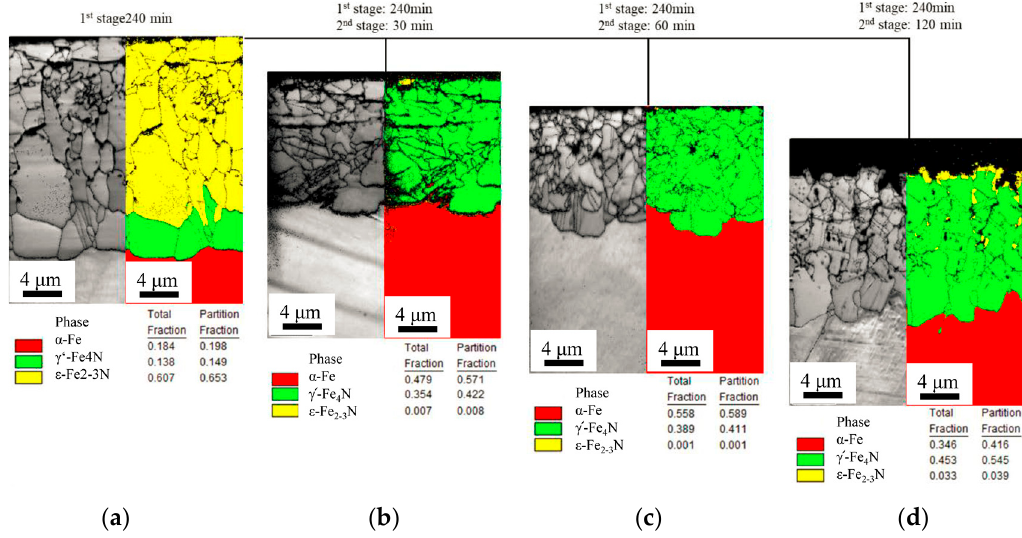
Figure 7. (Right side) phase map from the cross section gas-nitrided pure iron, with the phase relevant color coded map, α -Fe or α -Fe[N] (red), γ ’ phase (green), ε phase (yellow); (Left side) Cross-sectional SEM images from EBSD area: Gas-nitrided pure iron with 1st stage: 1.4 atm − 1/2 of nitriding potential for (a) only 1st stage: 240 min, and 2nd stage: 0.38 atm − 1/2 of nitriding potential at 570 °C for (b) 1st stage: 240 min and 2nd stage: 30 min, (c) 1st stage: 240 min and 2nd stage: 60 min and (d) 1st stage: 240 min and 2nd stage: 120 min.